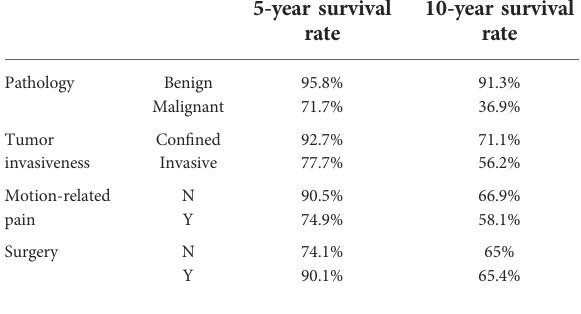
TABLE 4 Associations of the 5- and 10-year overall survival rates of the patients with different values for the four signi fi cant risk factors in fl uencing survival.